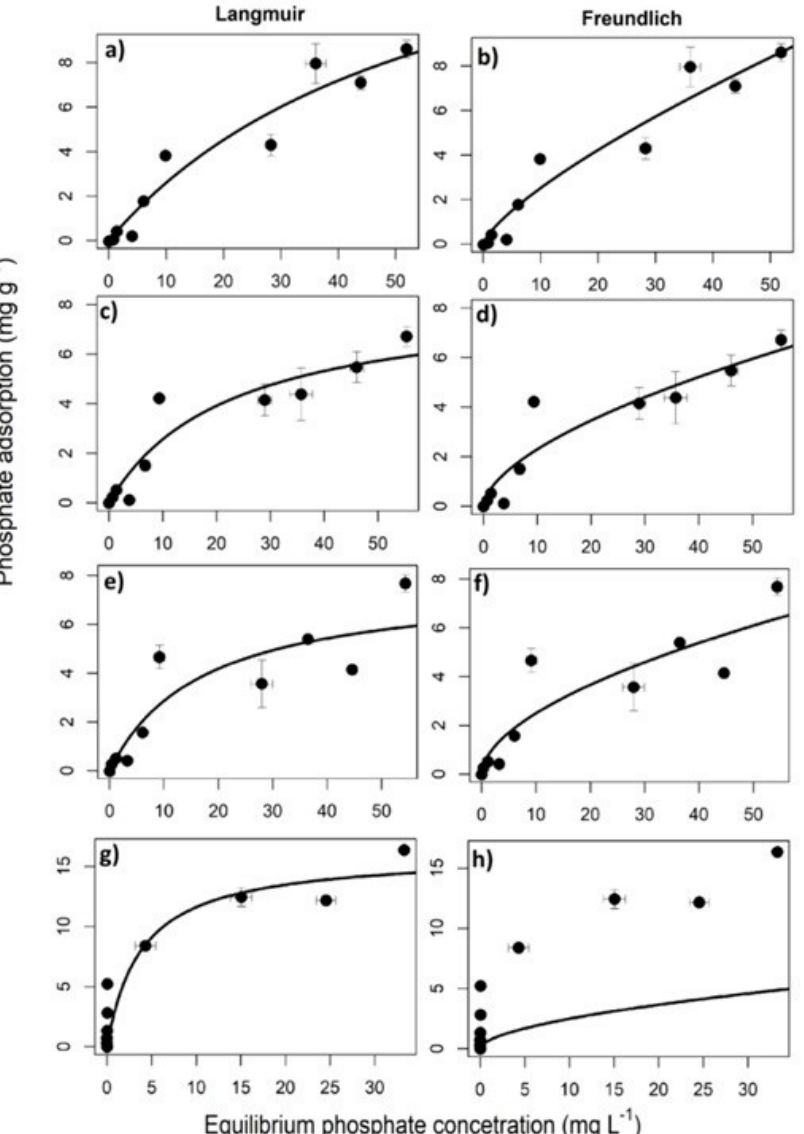
Figure 4. Langmuir (left) and Freundlich (right) adsorption isotherms for the adsorbent materials: (a) and (b) Luvisol; (c) and (d) Scheelite tailing; (e) and (f) Planosol; and (g) and (h) LMB. LMB= Lanthanum Modified Bentonite; SRP=Soluble Reactive Phosphorus.